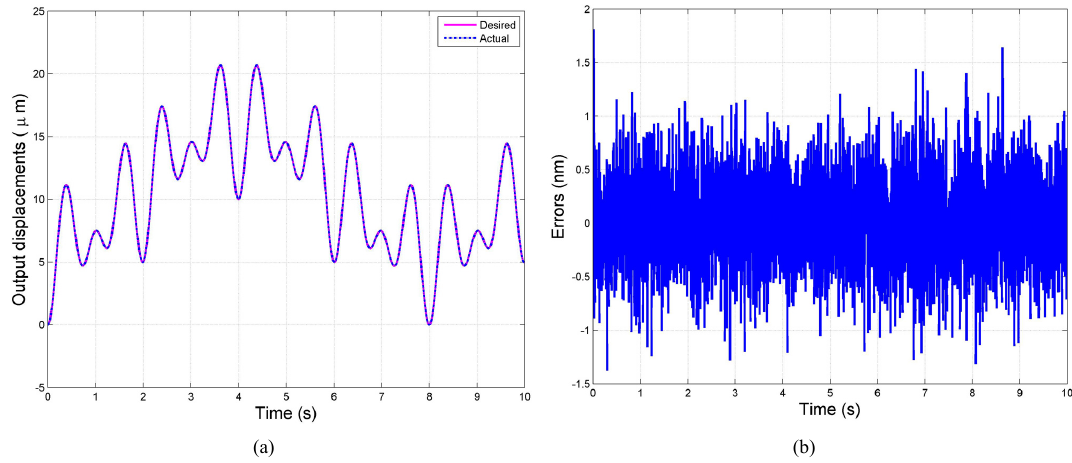
Figure 17. The tracking result and error: (a) the tracking result; (b) the tracking